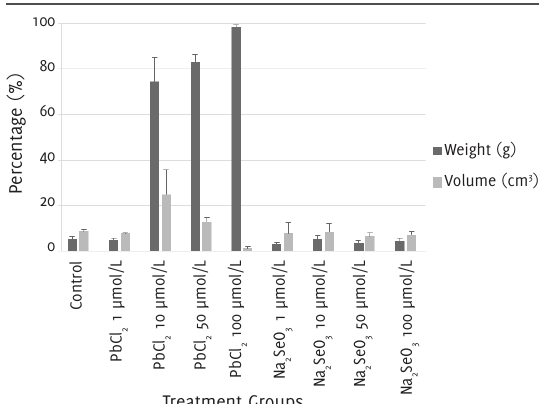
Figure 4. The Percentages of Apoptosis and Necrosis after 12 Days of Treatment with Lead (II) Chloride or Sodium